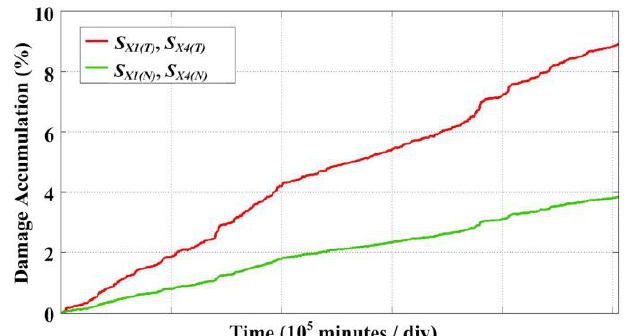
Figure 14. DA of the half-bridge IGBTs of the T-type inverter during the mission profile when R th(h − a) is 0.225 K/W or 0.145 K/W.